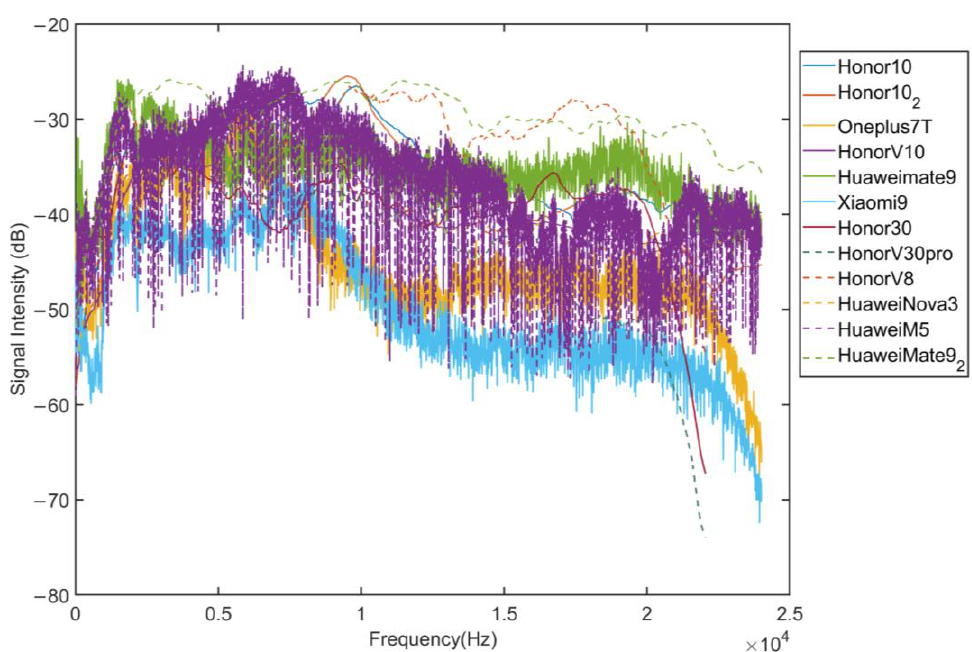
Figure 5. Frequency response characteristics of different mobile phones.